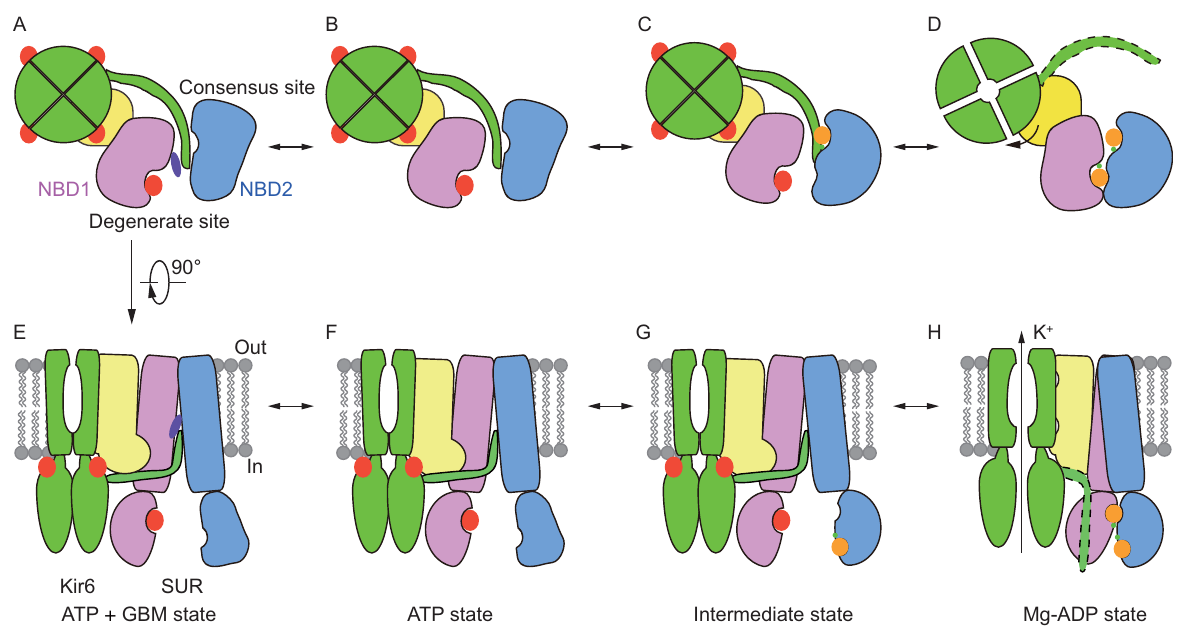
Figure 6. Model for nucleotide-induced NBD dimerization of the K ATP channel. (A – D) Bottom view of SUR1 cartoon models from cytosolic side. For simplicity, only CTDs of Kir6.2 and TMD0-L0 and NBDs from one SUR1 subunit are shown and colored the same as in Fig. 1A. KNtp with an unknown conformation in Mg-ADP state is outlined by dashed lines. ATP and ADP are shown as red and orange big spheres, respectively. Mg 2+ ions are shown as green small spheres. (E – H) Side view of SUR1 cartoon models. For simplicity, a pair of Kir6.2 and one SUR1 subunit